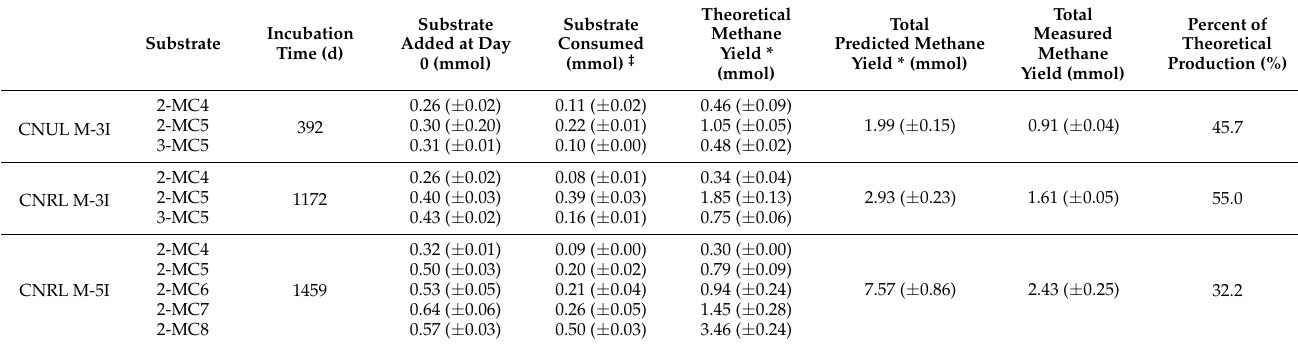
Table 1. Predicted and measured methane production in mature fine tailings with the degradation of iso -alkanes after